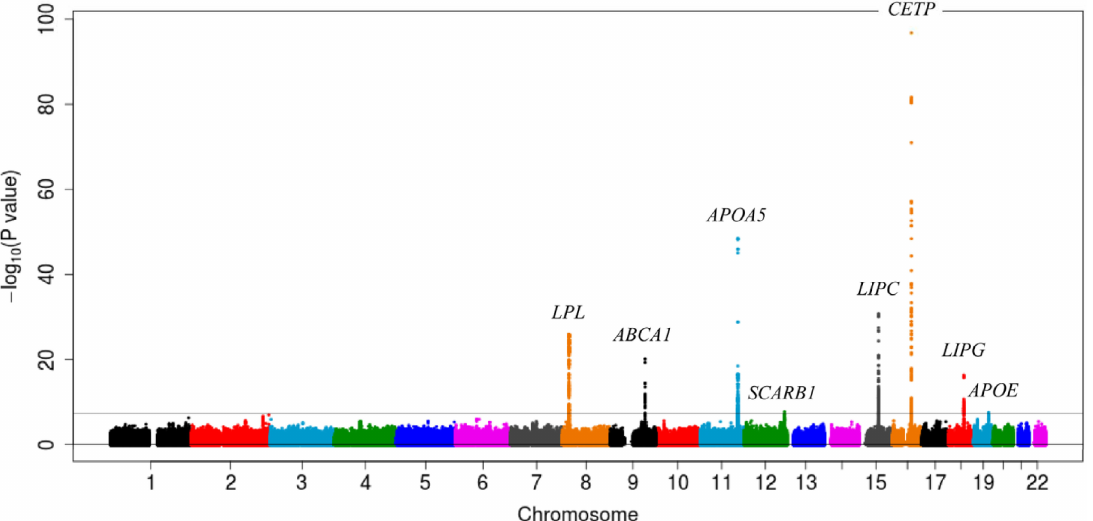
Figure 2. Manhattan plot ( % log 10 of the P value based on genomic location) of the association between the SNPs denoted in the original GWAS and the HDL-C levels shows the formation of eight peaks over the line representing P < 5 ' 10 % 8 for LPL (8p21.3), ABCA1 (9q31.1), APOA5 (11q23.3), SCARB1 (12q24.31), LIPC (15q21.3), CETP (16q13), LIPG (18q21.1), and APOE (19q13.32). The horizontal line represents the genome-wide signi fi cance level ( α = 5 ' 10 % 8 ). GWAS, genome-wide association study; HDL-C, high-density lipoprotein cholesterol; SNP, single-nucleotide polymorphism.